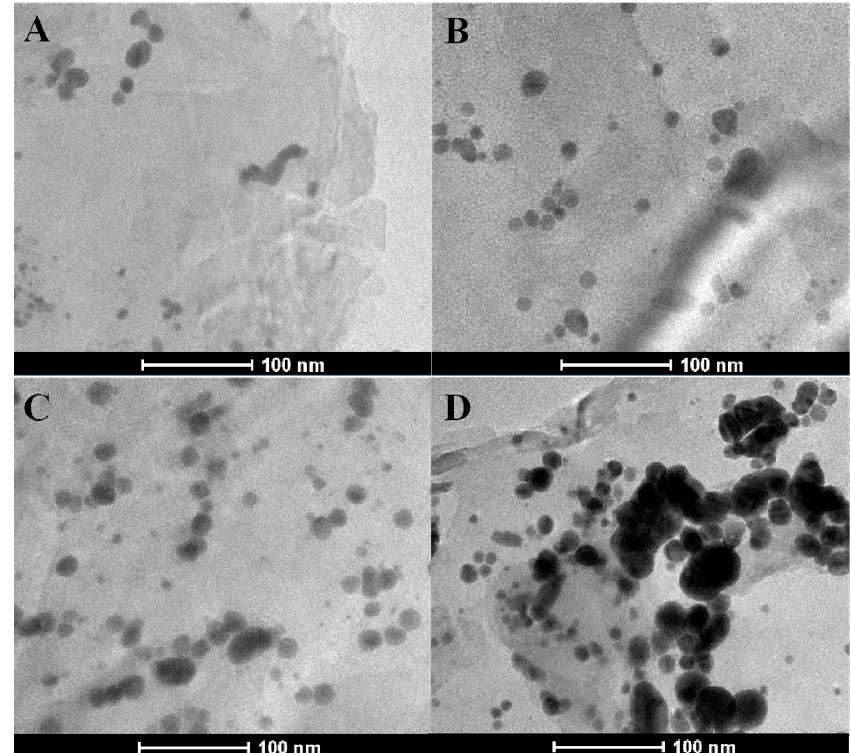
Figure 2. TEM images of AuNPs–BPNS synthesized while adding different concentrations of HAuCl 4 : ( A ) 10 mM; ( B ) 20 mM; ( C ) 25 mM; ( D ) 30 mM.